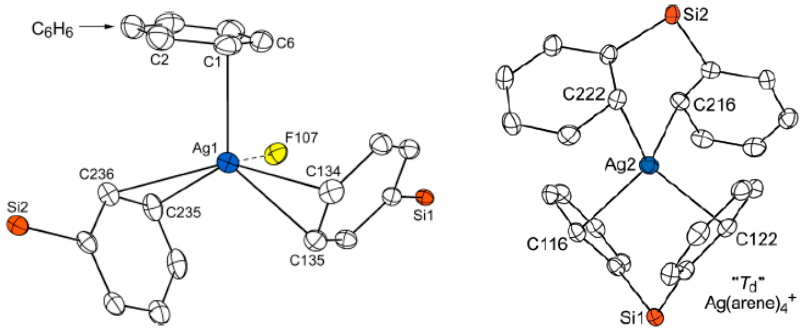
Figure 80. The coordination sphere of Ag atoms in the structure of {Ag[1-Me-1-CB 11 F 10 - 12-SiPh 3 ] ¨ 0.5(benzene)} n . Reprinted with permission from reference [102]. Copyright © (2007) American Chemical